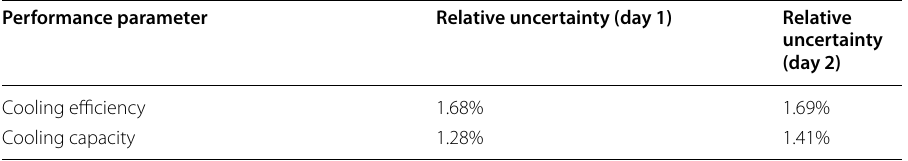
Table 4 Results of uncertainty analysis Performance